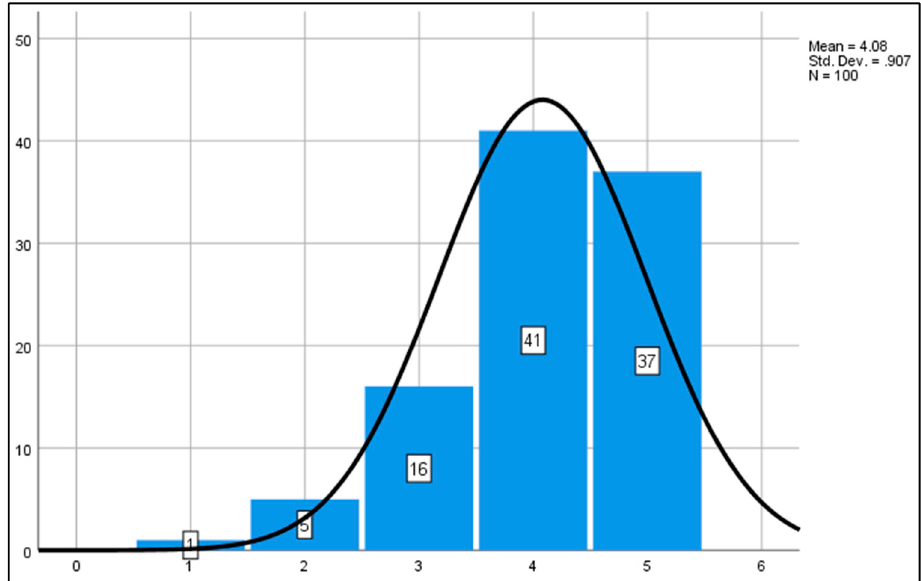
Figure 11 . Competencies and Industry 4.0 readiness.